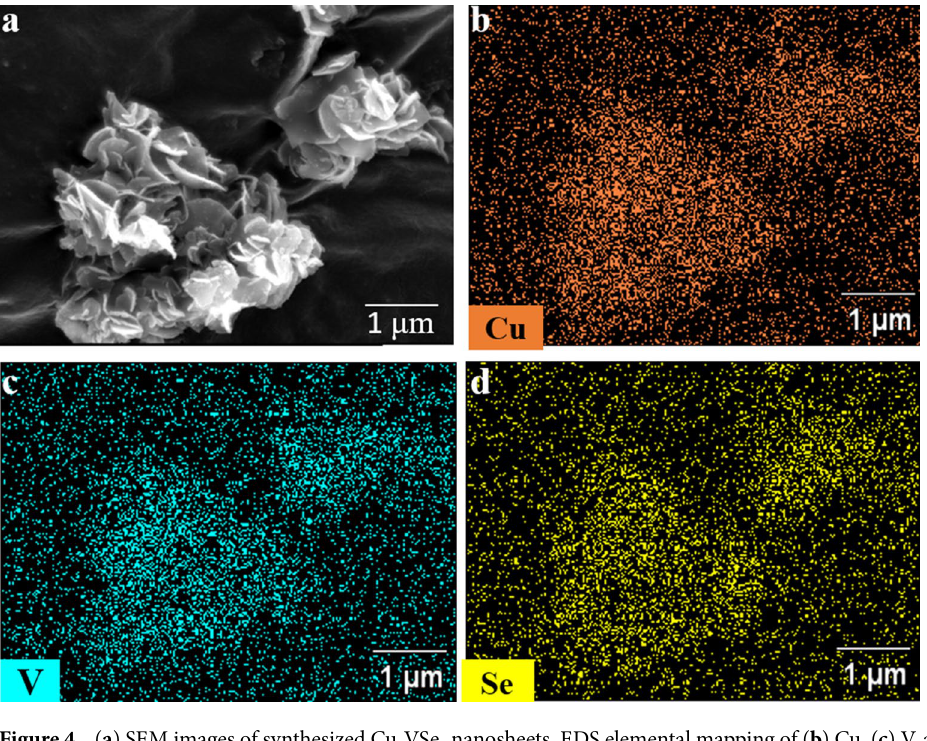
Figure 4. ( a ) SEM images of synthesized Cu 3 VSe 4 nanosheets. EDS elemental mapping of ( b ) Cu, ( c ) V, and ( d ) Se.